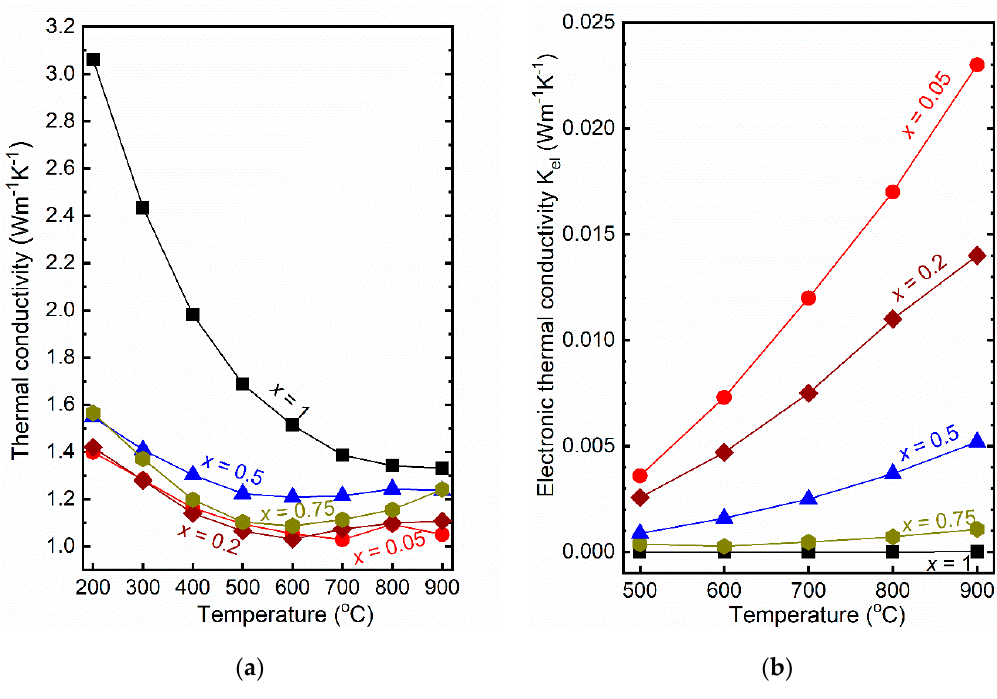
Figure 5. ( a ) Thermal conductivity of Ca 3 Co 2 − x Mn x O 6 , x = 0.05, 0.2, 0.5, 0.75, and 1 as a function of temperature; and ( b ) calculated electronic thermal conductivity as a function of temperature.